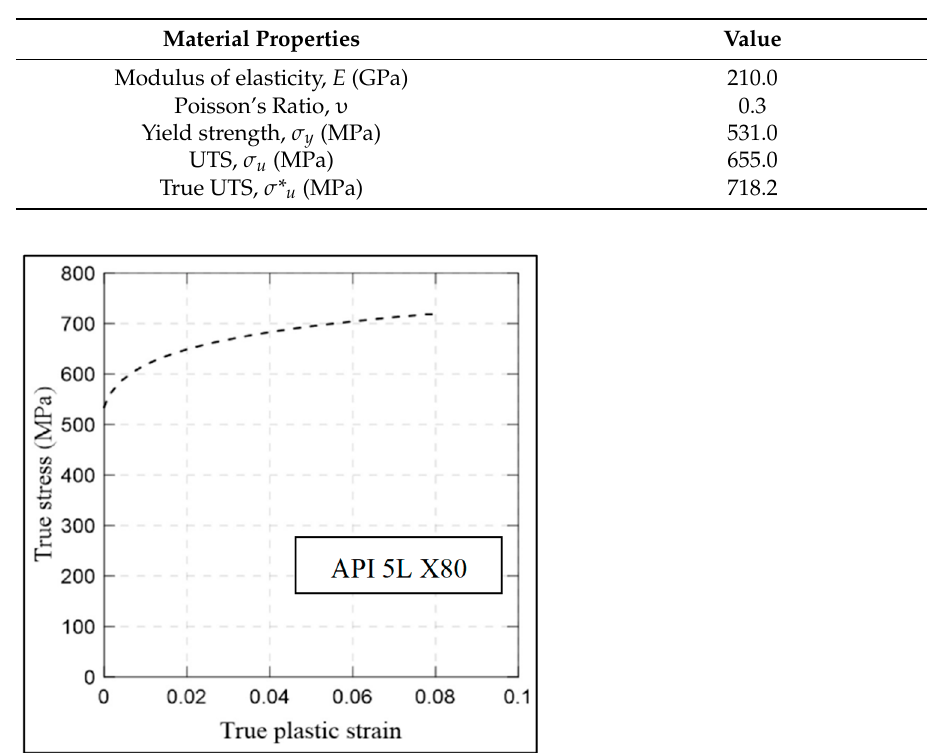
Table 9. Mechanical properties of API 5L X80.